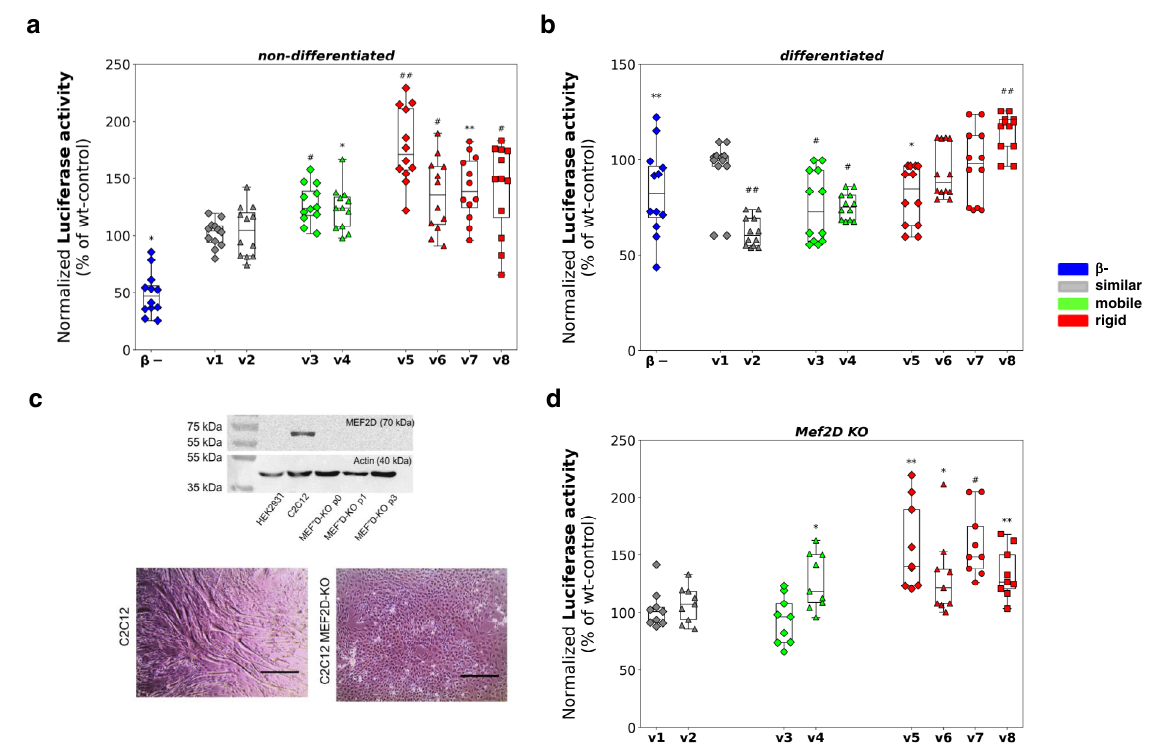
Fig. 2 | Transcriptional activity of MEF2D variants in C2C12 cells. Luciferase activity normalised to galactosidase signal (Methods) is shown as a percentage of the wild-type (wt) control. Luciferase activity was measured in four biologically independent experiments, using three technical replicates in each with the same samples ( n =12 samples in 4 independent experiments). The points represent individual measured data, the rectangles in the box plots present the median and the 25 and 75 percentile values, while the error bars point to 1 and 99%. The luci- ferasesignalisshownasmean ± SE,signi fi cance(* p <0.05;** p <0.01;# p <0.005; ## p<0.001) was computed using two-sided student t-test. The different variants are grouped by their β -domain dynamics properties (Fig. 1c, Methods): var1 (gray diamond) and var2 (gray triangle) with similar β -domain dynamics; var3 (green diamond) and var4 (green triangle) with mobile β -domain; var5 (red diamond), var6 (red triangle), var7 (red circle) and var8 (red square) with rigid β -domain as compared to the wild-type. The β - variant is shown by blue diamond. a Transcriptionalactivityinnon-differentiatedC2C12myoblasts.Variantswithrigid β -domains show signi fi cantly higher transcriptional activity then the wild-type ( var5 178±9.6, var6 135.6±9.3, var7 141.6±8.1 and var8 140.8±11.5 %), while var- iants with mobile β -domains show slightly increased transcription activity ( var3 127.7±4.9 and var4 123.9±5.5 %) using n =12 samples in 4 independent experi- ments. Signi fi cances ( var3 p =0.0001, var4 p =0.0012, var5 p =5.2*10 − 6 , var6 p =0.0027, var7 p =0.0003, var8 p =0.0044; β -minus p =1.52*10 − 6 ) were